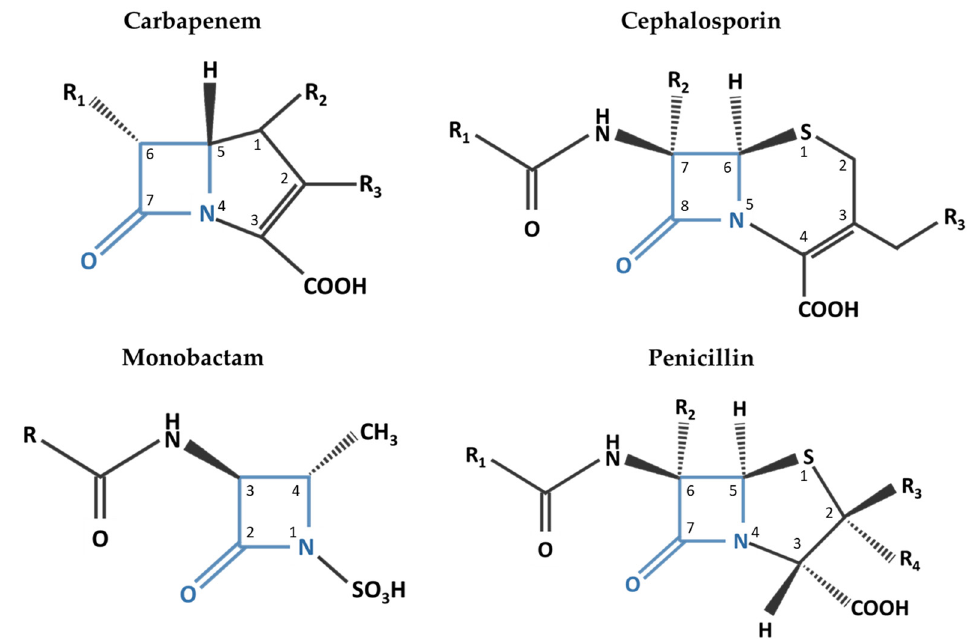
Figure 1. Molecular Structure of the Beta-Lactams.